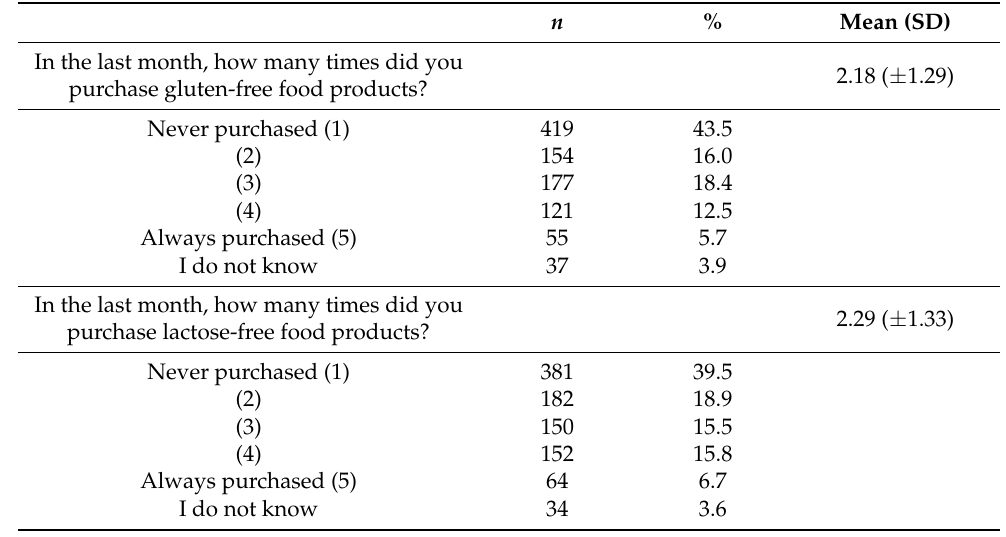
Table 2. The frequency of purchase of lactose-free and gluten-free food products ( n = 963). n % Mean (SD) In the last month, how many times did